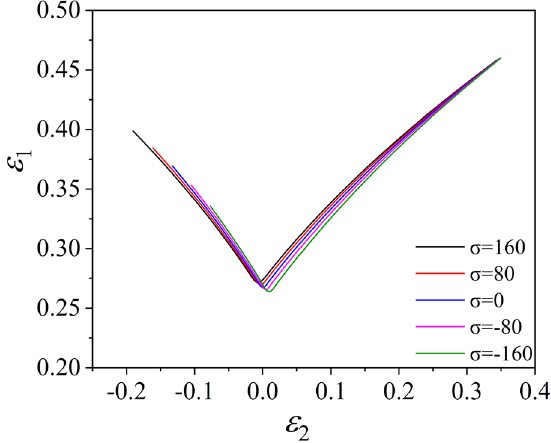
Figure 7. FLD of material TRIP780 based on Mises yield criterion and MMFC instability criterion.